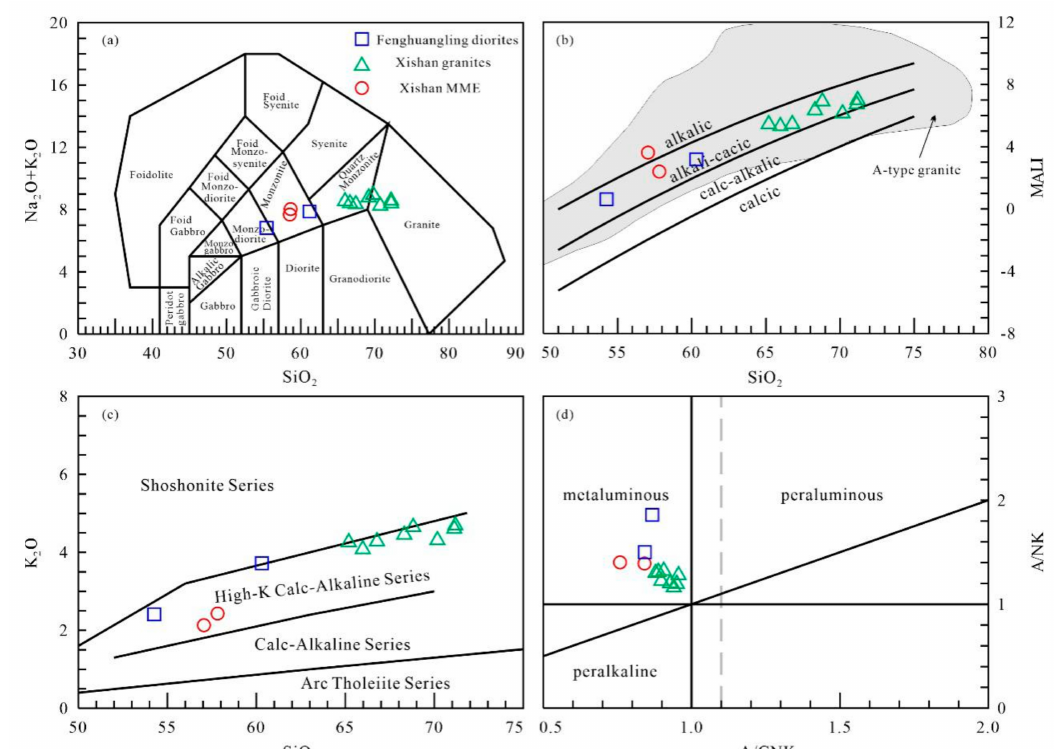
Figure 5. Chemical characteristics of the Guiping complex. ( a ) SiO 2 versus total alkalis diagram (after Middlemost, 1994) [47]; ( b ) SiO 2 versus MALI diagram (after [48]); ( c ) SiO 2 versus K 2 O diagram (after [49]); ( d ) an A/CNK versus A/NK diagram (after [50]).